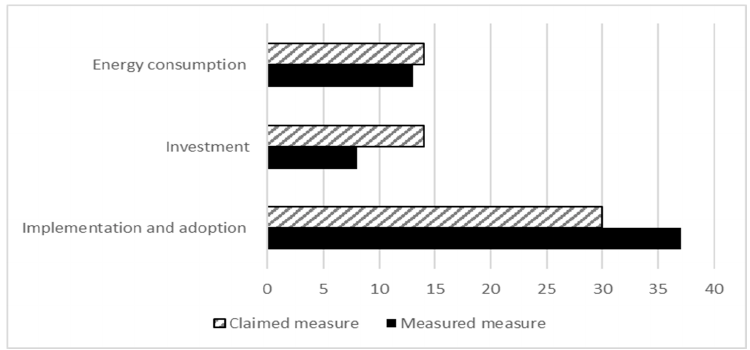
Figure 5. Distribution of the dependent variable, energy efficiency, according to measurement.